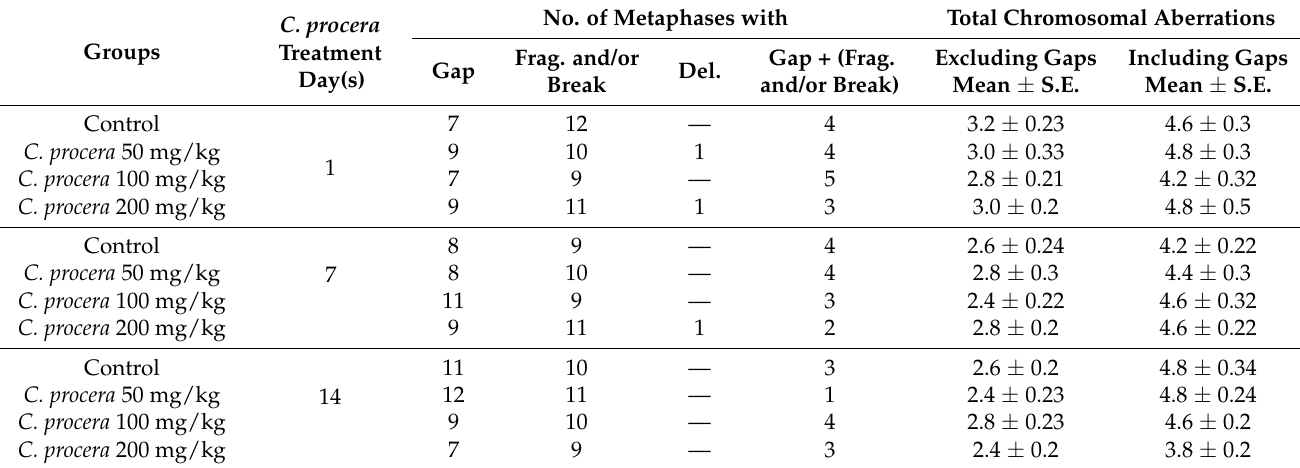
Table 4. Number and mean percentages of different chromosomal aberrations in bone marrow cells of mice after treatment with different doses of C. procera for 1, 7, and 14